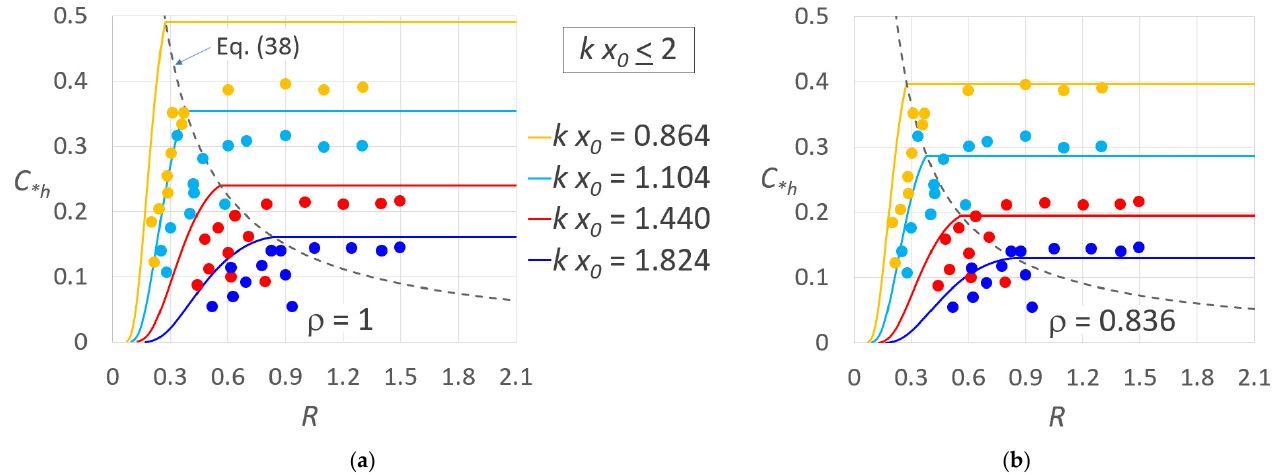
Figure 10. Relationship between the normalized hydraulic loading rate, C *h (Equation (36)), versus R ( a ) for ρ = 1 and ( b ) for ρ = 0.836 for the k x 0 values ( k x 0 ≤ 2), corresponding to the experimental measurements carried out by d’Antonio and Carbone [34]. The corresponding values derived by d’Antonio and Carbone [34] are also plotted.